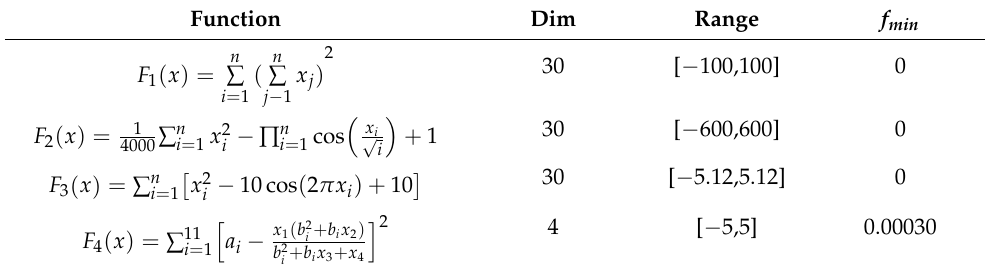
Table 1. Benchmark